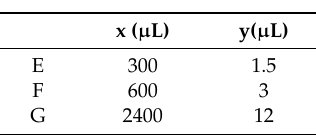
Table 2. Amounts of gold (III) chloride solution (x ( µ L)) and acetic acid (y ( µ L)) used to synthesise acetic acid stabilized gold nanoparticles.